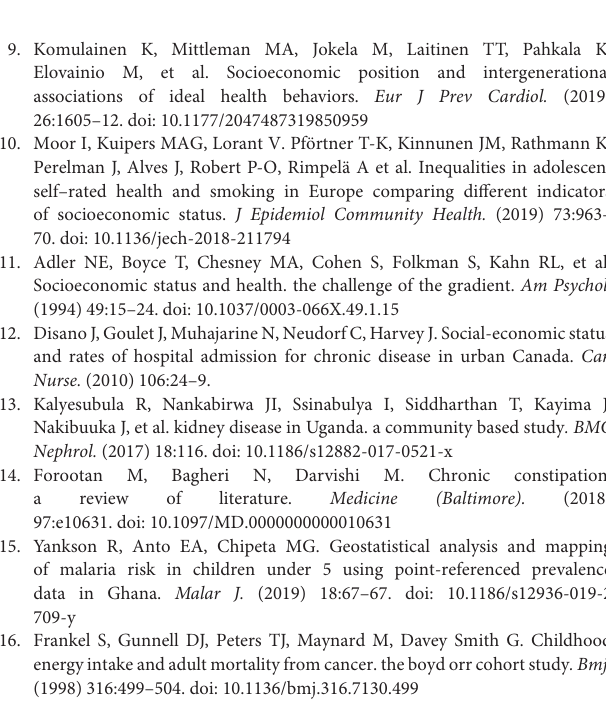
Supplementary Figure 1 | Begg funnel plots of population-based cohort studies of family SEP and lung cancer (unadjusted group). Supplementary Figure 2 | Begg funnel plots of population-based cohort studies of family SEP and lung cancer (adjusted group). Supplementary Figure 3 | Sensitivity analysis of population-based cohort studies of family SEP and lung cancer (unadjusted group). Supplementary Figure 4 | Sensitivity analysis of population-based cohort studies of family SEP and lung cancer (adjusted group). Supplementary Figure 5 | Dose response of childhood housing conditions and lung cancer (adjusted group) (top left), family economic conditions and lung cancer (adjusted group) (top right), childhood housing conditions and lung cancer (unadjusted group) (bottom left), family economic conditions and lung cancer (unadjusted group) (bottom right). Supplementary Table 1 | Summary of identified MR gene bank of exposure. Supplementary Table 2 | Summary of identified MR gene bank of outcome. Supplementary Table 3 | Characteristic of the included studies in the meta-analysis. Supplementary Table 4 | The Newcastle-Ottawa quality assessment scale of including studies. Supplementary Table 5 | Data from included cohort